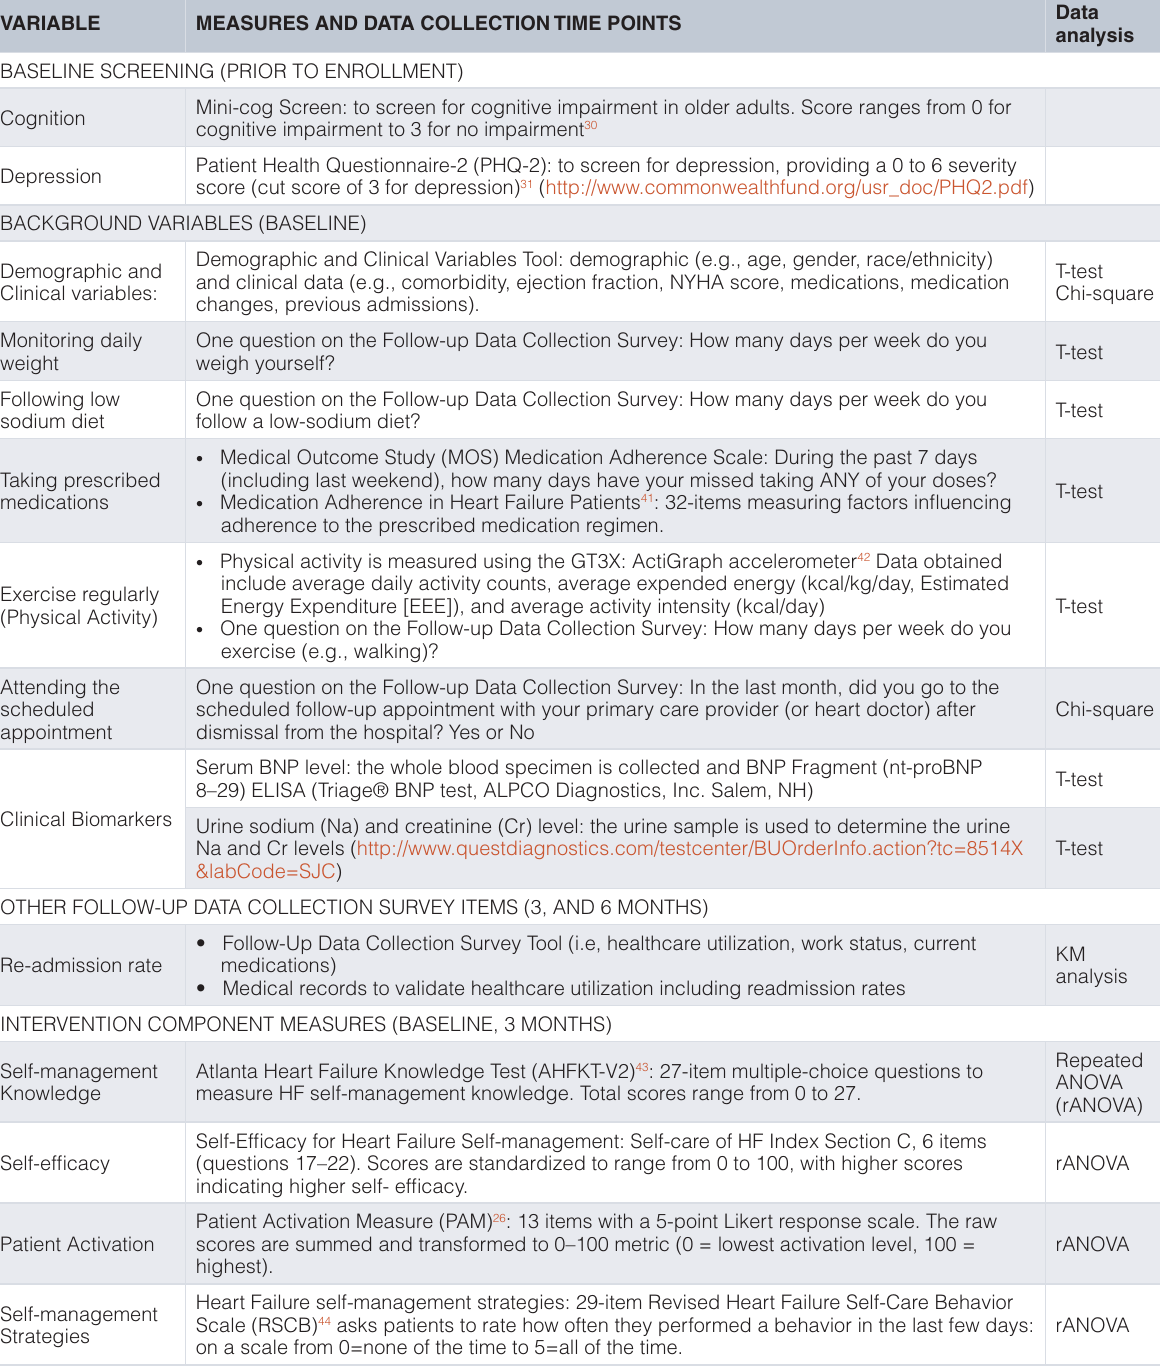
Table 1. Data Collected in the Study. VARIABLE MEASURES AND DATA COLLECTION TIME